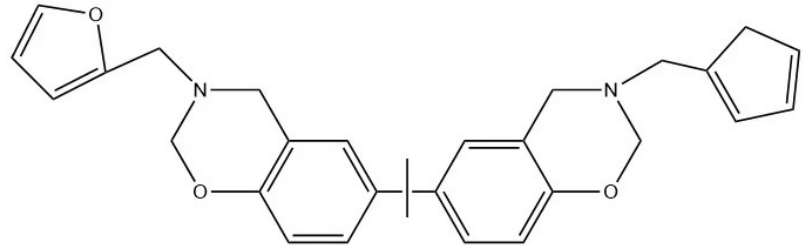
Figure 10. The structure of bisphenol-A-furfuryl amine benzoxazine. Figure 10 . The structure of bisphenol ‐ A ‐ furfuryl amine benzoxazine . The FTIR spectrum of benzoxazine (bisphenol A) was shown in Figure 11. The result Figure 10 . The structure of bisphenol ‐ A ‐ furfuryl amine benzoxazine . was shown in Table Table 5. The result of FTIR spectrum of benzoxazine (bisphenol A) [15,16]. Functional Group Peak Table 5. The result of FTIR spectrum of benzoxazine (bisphenol A) [15,16].